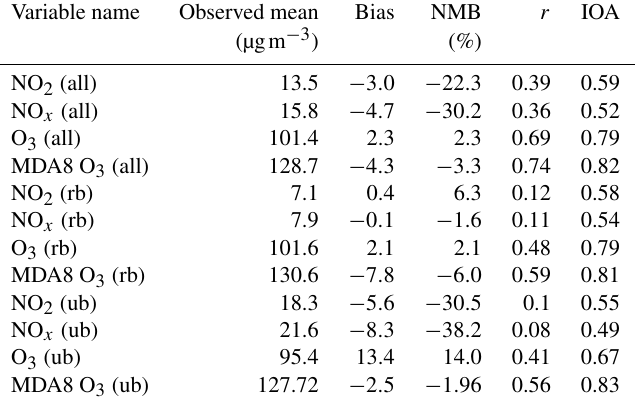
Table 4. Observed mean and simulation summary statistics for NO 2 , NO x , O 3 , and MDA8 O 3 concentrations. The bias, normalized mean bias (NMB), correlation coefficient ( r ), and index of agreement (IOA) are calculated between simulated and observed concentrations at the German background (all), urban and suburban backgrounds (ub), and rural (rb) stations during the 6–13 August 2015